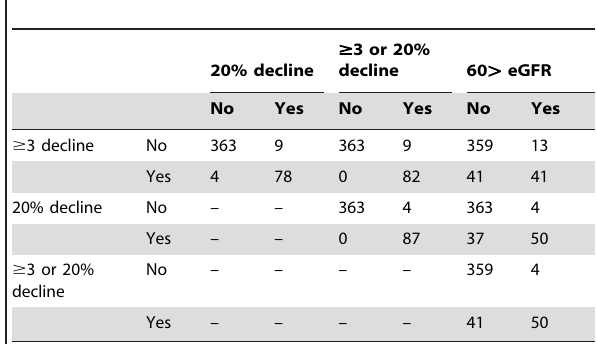
Abbreviations: eGFR, estimated glomerular filtration rate.